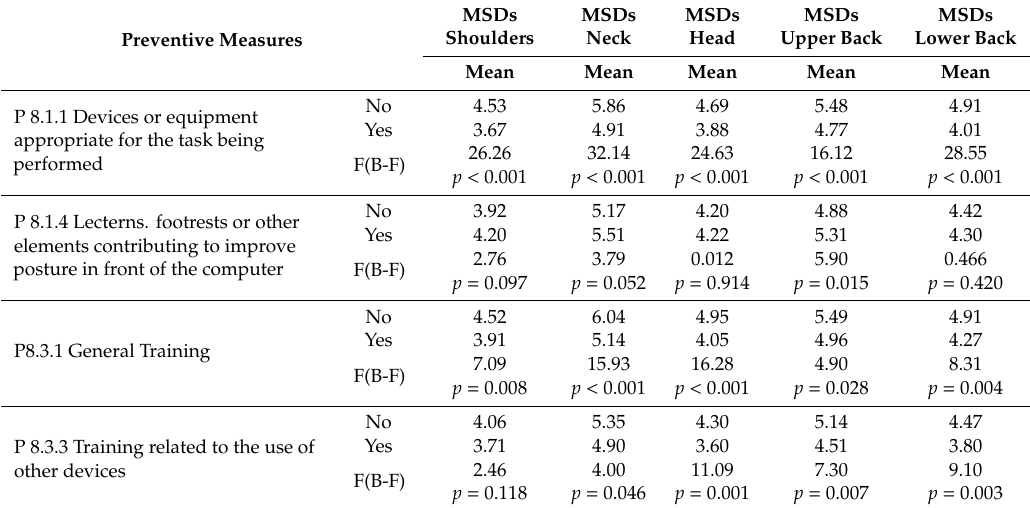
Table 8. Relations between preventive measures. Visual discomfort. And musculoskeletal disorders (2). Preventive Measures